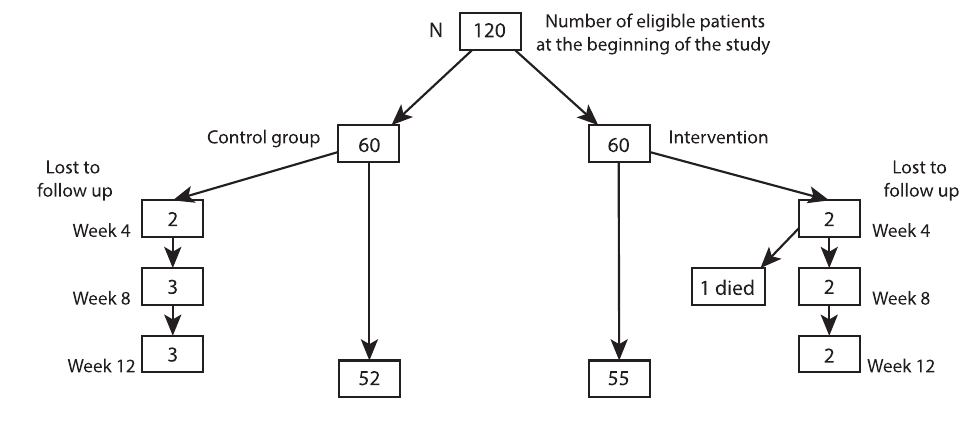
Figure 1: Distribution of the study population.